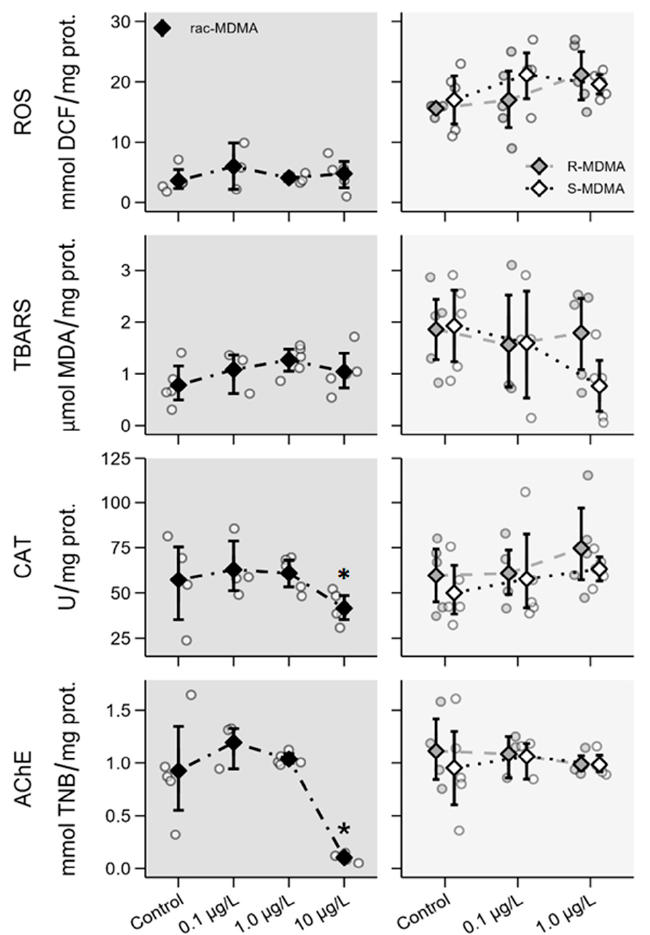
Figure 7. Biochemical effects of ( R,S )-MDMA ( left ; dark grey panels) and its enantiomers ( right ; light grey panels) determined on day 8 in Daphnia magna . Data are presented as individual observations (circles), mean values (diamonds) and 95% bootstrap confidence intervals (error bars). Asterisks (*) represent significant differences relative to the control.